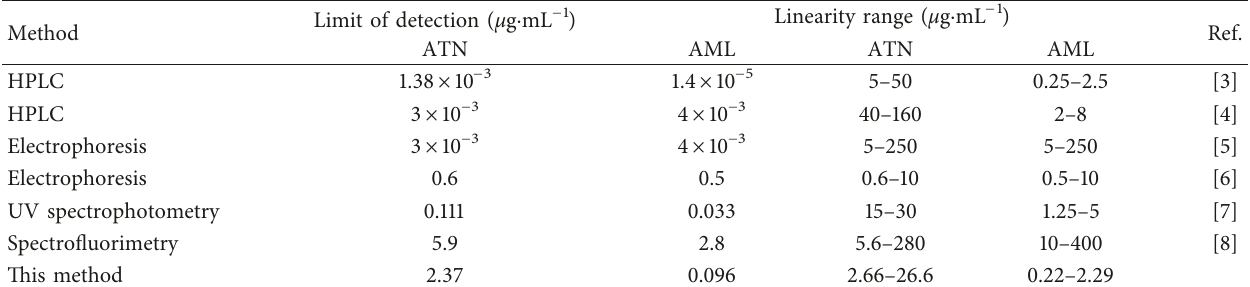
Table 6: A comparison between different approaches used for simultaneous determination of ATN and AML.